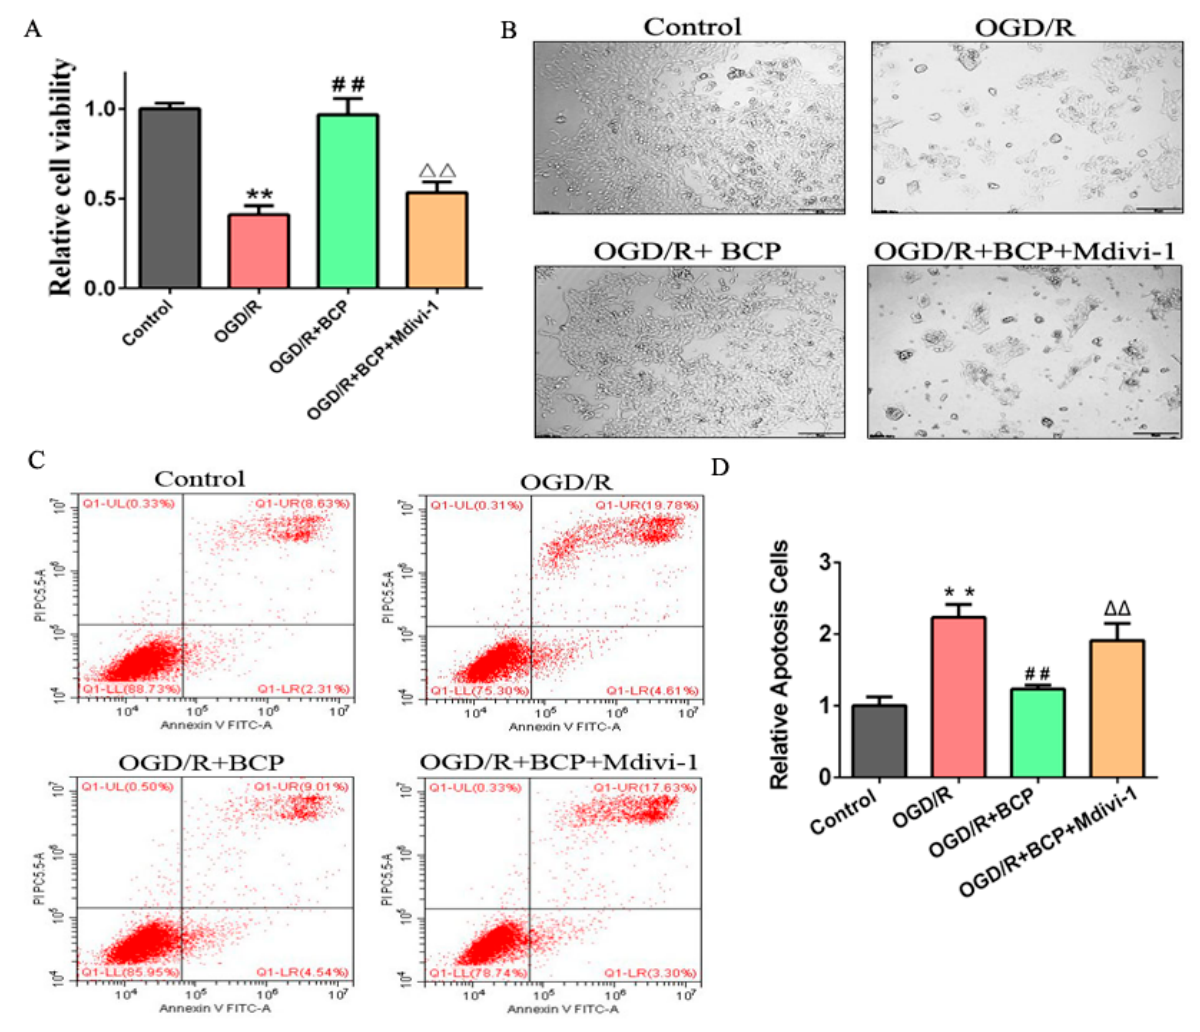
Figure 5. Facilitating mitophagy plays an important role in BCP protection against OGD/R injury of HT-22 cells. ( A ) Effect of BCP on cell viability of OGD/R-injured HT-22 cells after treatment with the mitophagy inhibitor Mdivi-1. ( B ) HT-22 cells were observed by microscopy after treatment with Mdivi-1. ( C , D ) Flow cytometry and quantitative analysis of apoptosis of OGD/R cells after treatment with Mdivi-1. ( n = 3; ** p < 0.01 OGD/R group vs. control group; ## p < 0.01 OGD/R + BCP group vs. OGD/R group; (cid:52)(cid:52) p < 0.01 Mdivi-1 group vs. BCP group). Additionally, we evaluated mitophagy levels after exposure to Mdivi-1. We found that Mdivi-1 reversed the BCP-mediated decreases in expression of TOM20 and p62, and increase in the LC3-II/LC3-I protein ratio in OGD/R cells (Figure 6A–D). Consistently, Mdivi-1 blocked the BCP-induced increase of autophagic vacuoles wrapping around dam- aged mitochondria in OGD/R cells (Figure 6E,F). Furthermore, Mdivi-1 blocked the sig- nificant BCP-induced increase of Parkin2/VDAC1-positive cells following OGD/R injury (Figure 6G,H). In addition, Mdivi-1 reversed the BCP-mediated decrease in mtDNA copy numbers in OGD/R cells (Figure 6I). Finally, Mdivi-1 reversed BCP-mediated increases in Pink1 and Parkin2 protein expression levels in OGD/R cells (Figure 7A–C). In accor- dance with mitochondrial translocation assay results, Mdivi-1 blocked BCP-mediated increases of Parkin2/VDAC1-positive cells (Figure 7D,E). Therefore, BCP mediated protec- tion against OGD/R-mediated injury in HT-22 cells mainly by facilitating mitophagy via the Pink1/Parkin2